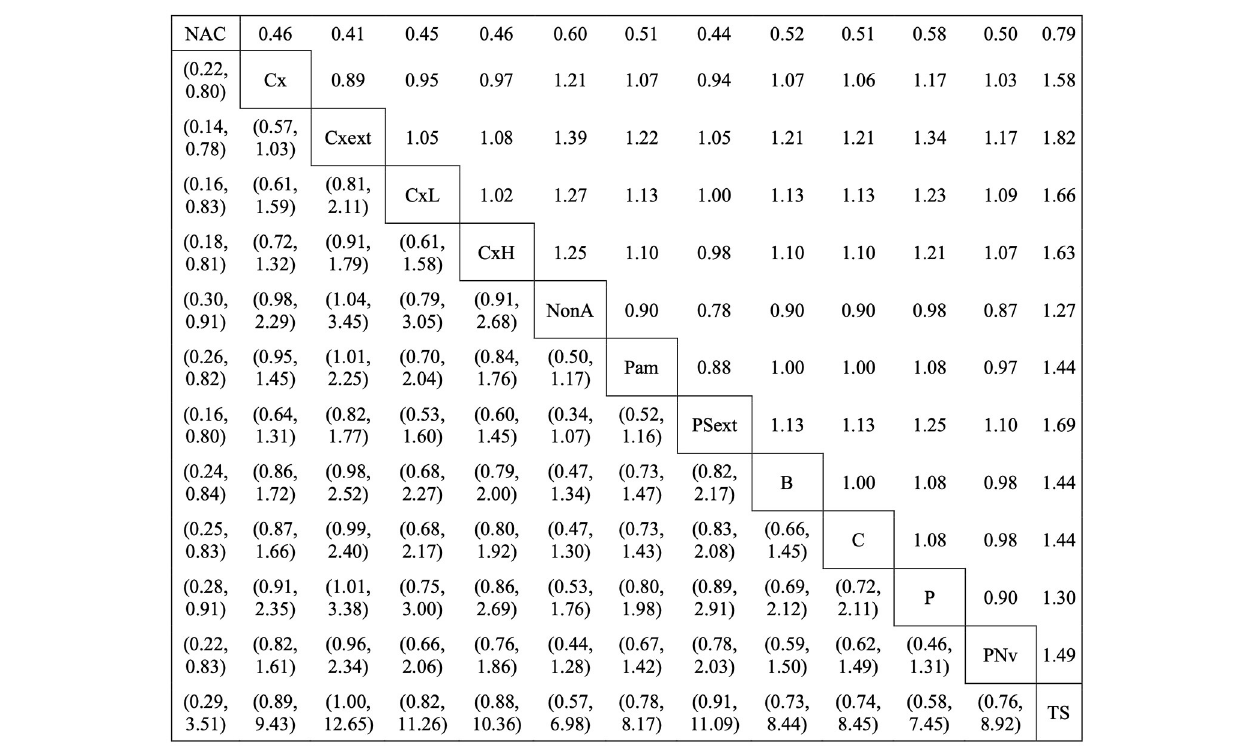
FIGURE 3 | The relative risk ratios ( RR ) of currently labeled antimicrobial treatment protocols in Canada and the United States that were assessed in the network for the all-cause cure of existing intramammary infections during the dry period. The right-hand side of the matrix indicates the RR of row treatment compared with the column treatment (i.e., the risk of experiencing a cure with non-active control is 0.46 times the risk of experiencing a cure with cloxacillin). The left-hand side of the matrix indicates the 95% credibility intervals ( CI ) for each RR . The treatment acronyms are as follows: non-active control (NAC), cloxacillin (Cx), cloxacillin–extended therapy (Cxext), cloxacillin–low dosage (CxL), cloxacillin—high dosage (CxH), non-antimicrobial treatment (NonA), penicillin/aminoglycoside combinations (Pam), penicillin/streptomycin–extended therapy (PSext), ceftiofur (B), cefapyrin (C), penicillin (P), penicillin/novobiocin (PNv), teat sealant (TS) ( Table 2